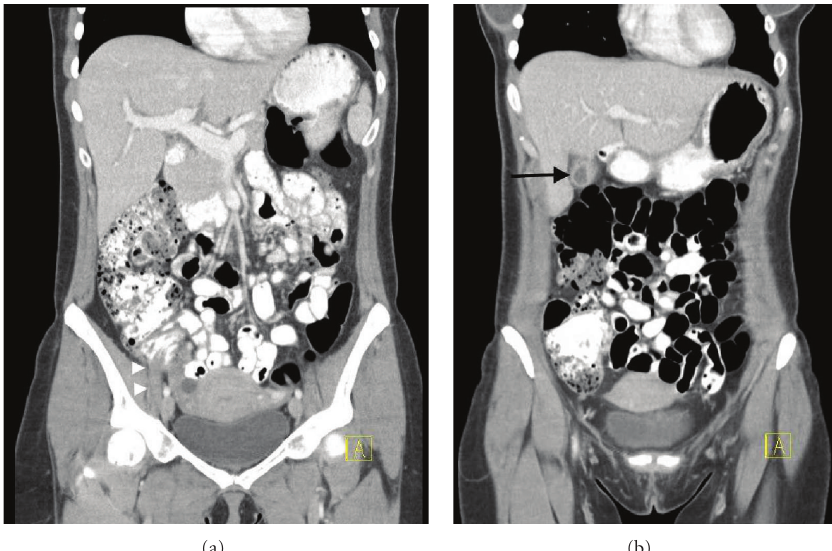
Figure 1: CT abdomen and pelvis, with oral and IV contrast. Note the dilated appendix (white triangles) on the left panel and the inflamed gallbladder (black arrow) on the right panel.